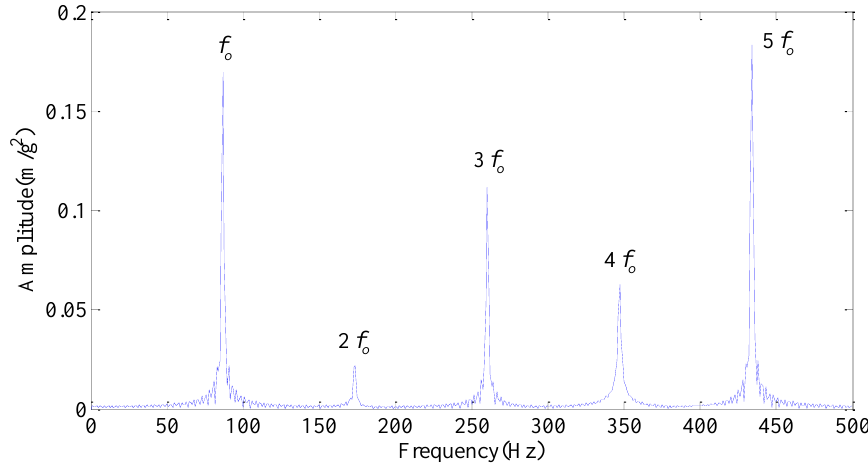
Figure 9. The result provided by improved DMD.